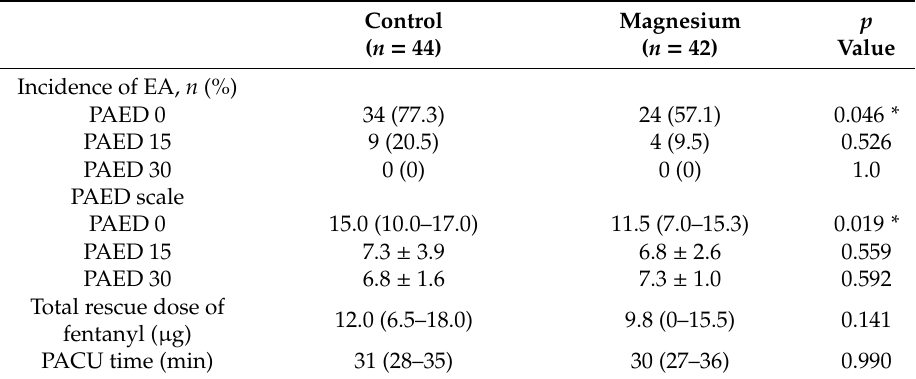
Table 3. Postoperative emergence agitation at